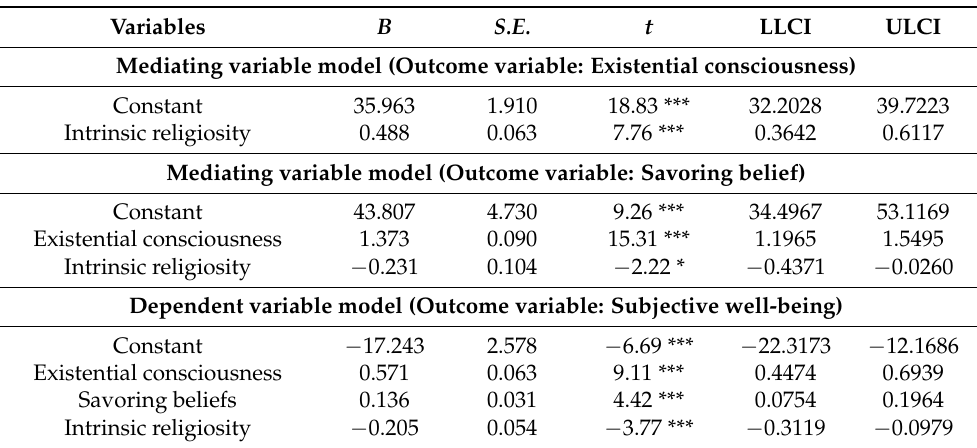
Table 3. Double mediating effect of existential consciousness and savoring beliefs on the intrinsic religiosity and subjective well-being of middle-aged Korean women.